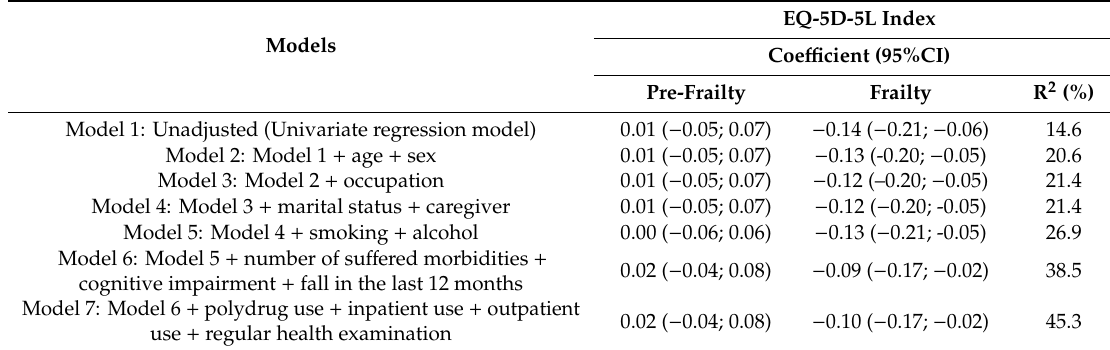
Table 5. regression models to identify the association between frailty status and health-related quality of